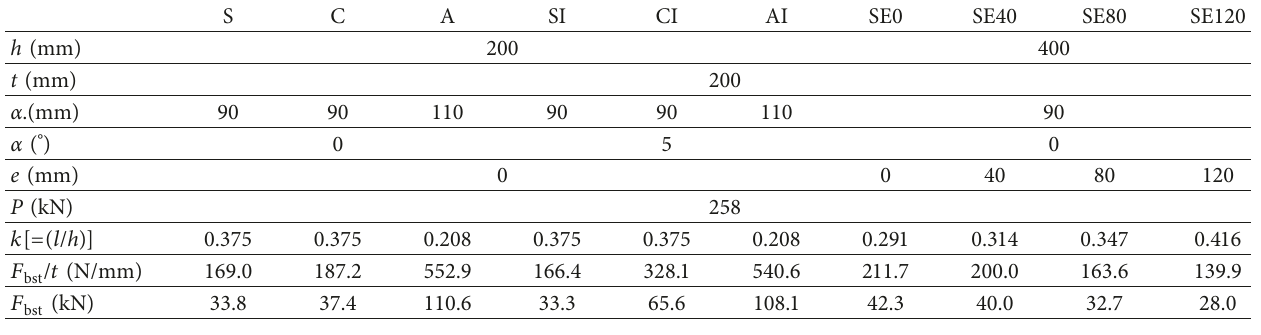
Table 3: Bursting forces and variables.